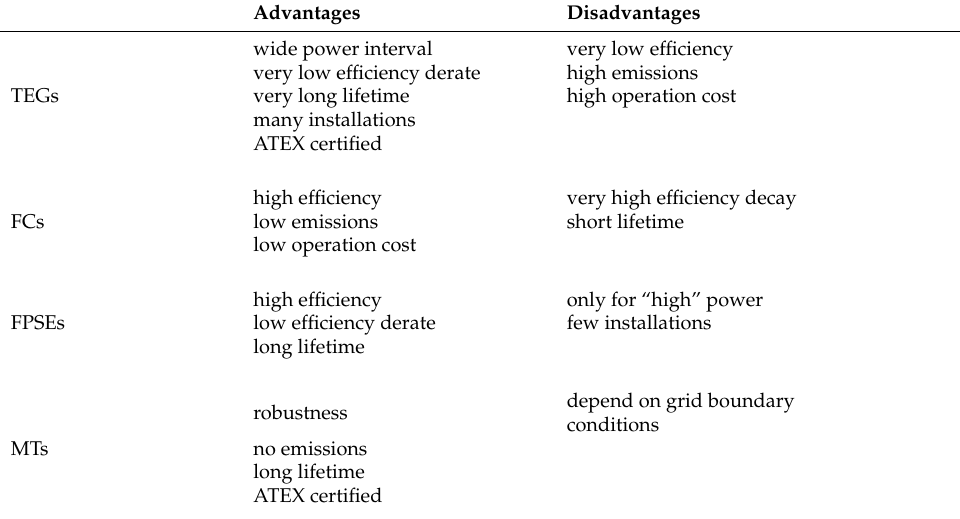
Table 5. Main advantages and disadvantages of the power generating